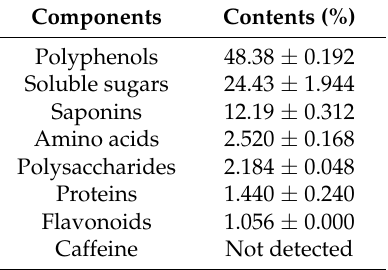
Table 1. Chemical compositions in the water extract from the buds of Castanopsis lamontii (CLE).